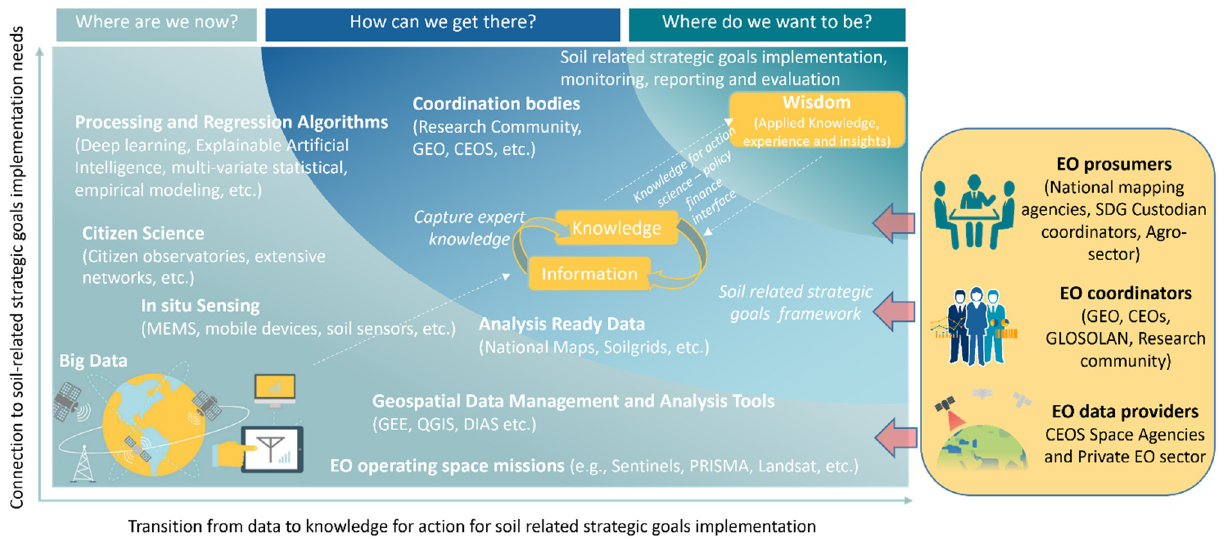
Figure 2. Research from the EO and soil communities needs to focus on the Data–Information–Knowledge–Wisdom pathway to be relevant for the implementation of the soil-related strategic goals. EO prosumers—non-traditional end-users who are adopting EO as both data consumers and information producers—have a key role to play in generating knowledge using EO to monitor and drive progress on soil mapping and reporting (inspired from Kavvada et al. [10]).